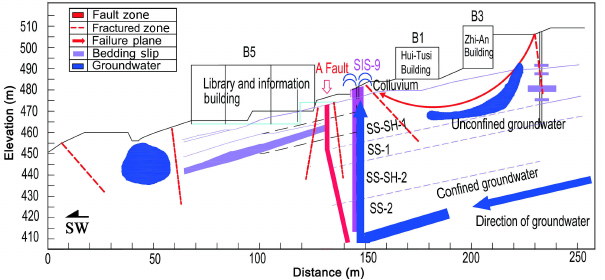
Figure 5. Hydrogeological profile